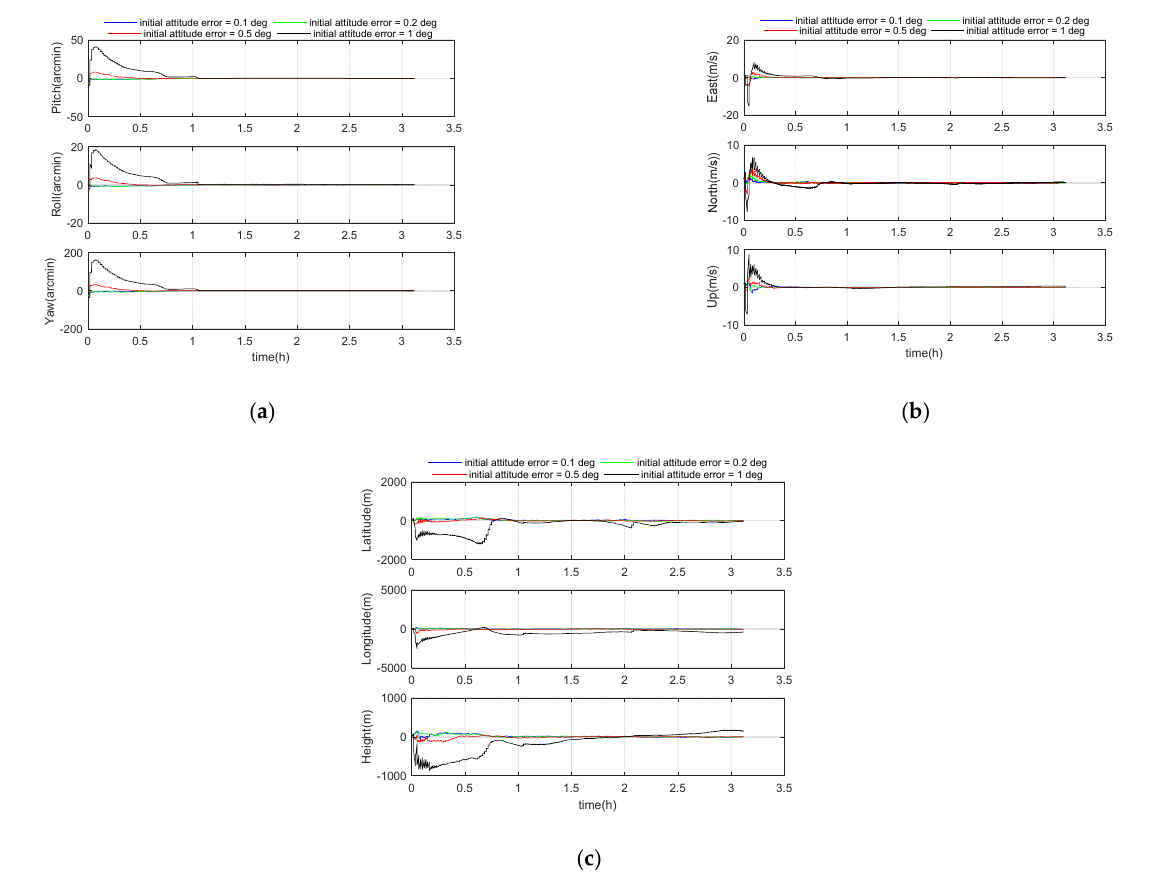
Figure 7. ( a ) Attitude error curve; ( b ) velocity error curve; ( c ) position error curve. Table 6. Simulation results of different initial attitude errors.